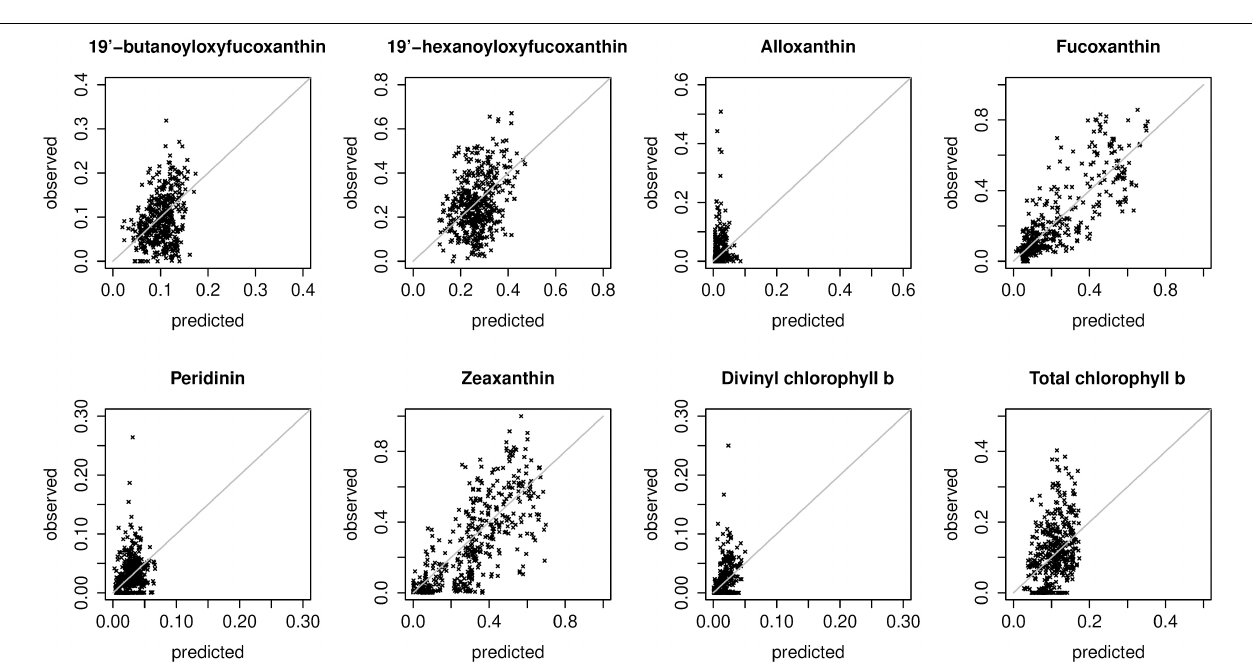
FIGURE 3 | Reduction of mean absolute error (in comparison to a null model which always predicts the mean of the training data) of the best-performing abundance-based, spectral and ecological algorithms for each diagnostic pigment.